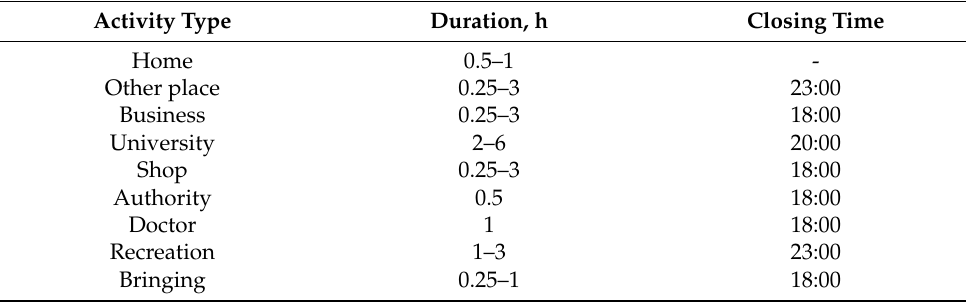
Table A2. Durations by activity type.